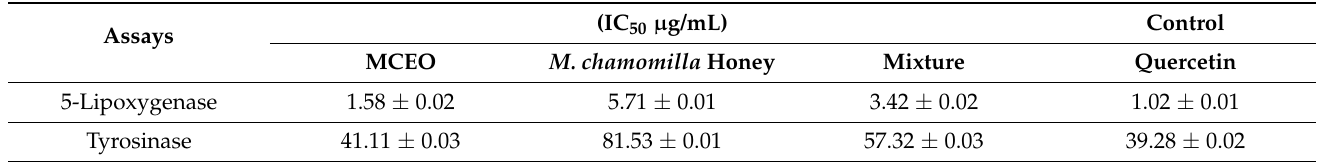
Table 6. In vitro anti-inflammatory and dermatoprotective activity of MCEO, M. chamomilla honey and mixture. .